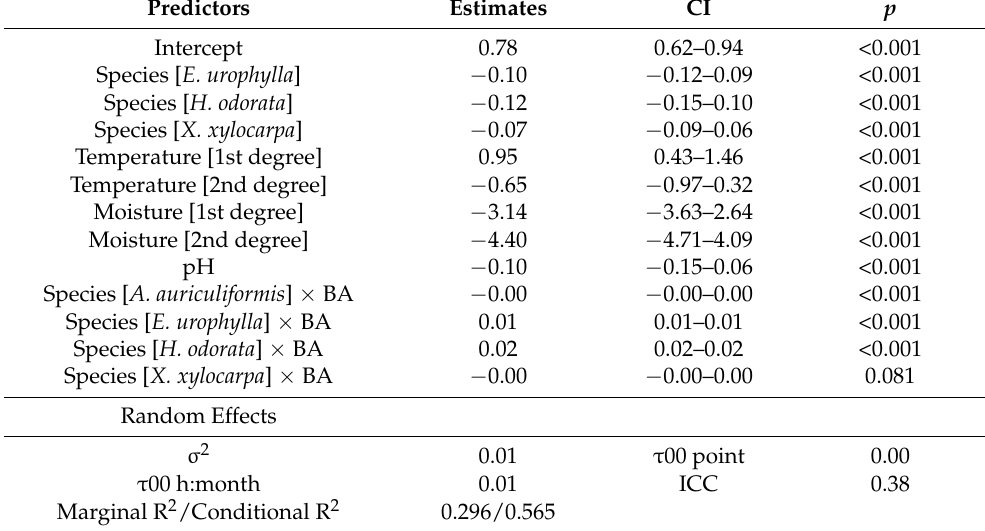
Table A2. Estimates, 95% confidence intervals (CI), and p -values of fixed-effects predictors for soil res- piration, including tree species, soil temperature ( ◦ C), soil moisture (%), soil pH, and basal area (BA; cm 2 m − 2 ), based on a mixed-effects model. The overall variance ( σ 2 ) and intraclass correlation coeffi- cient (ICC) are reported for the random effects, including hour, month, and measurement